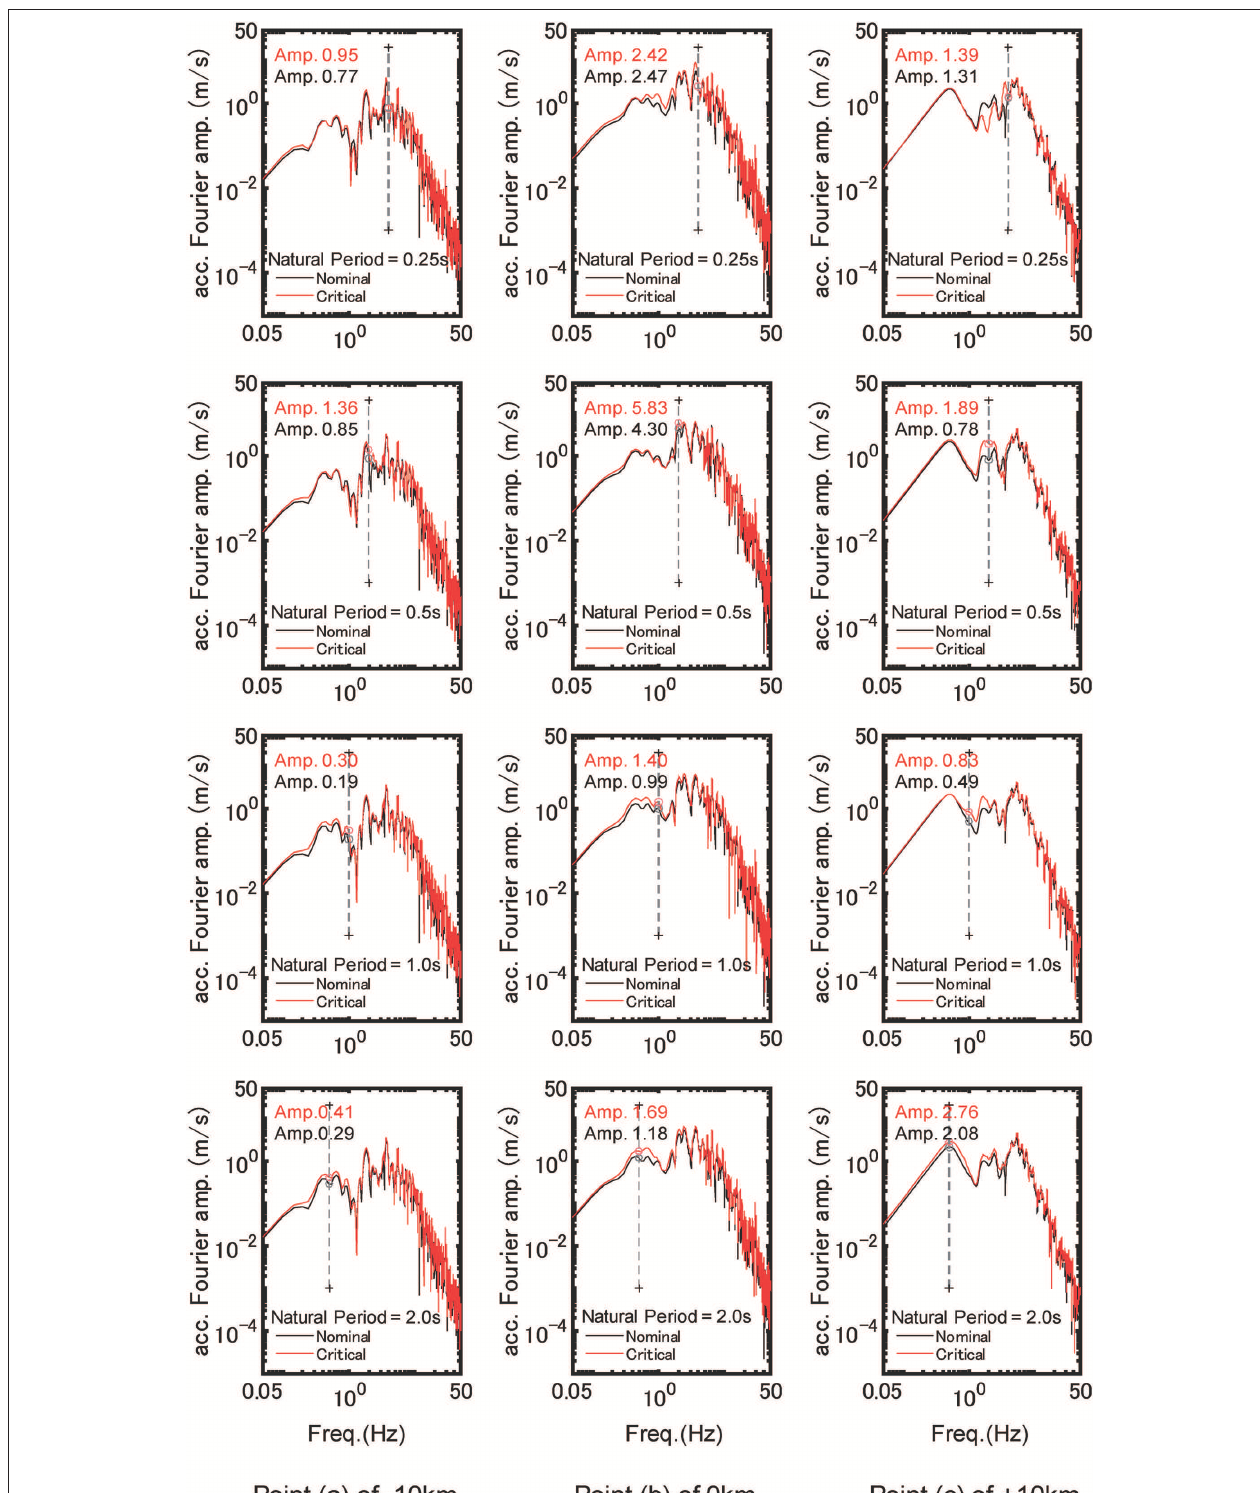
FIGURE 8 | Fourier amplitude spectra of nominal and critical ground surface accelerations of four MDOF models with different number of stories ( T 1 = 0.25 s ,0.5 s , 1.0 s , 2.0 s ) at three points (Straight lowest natural mode).